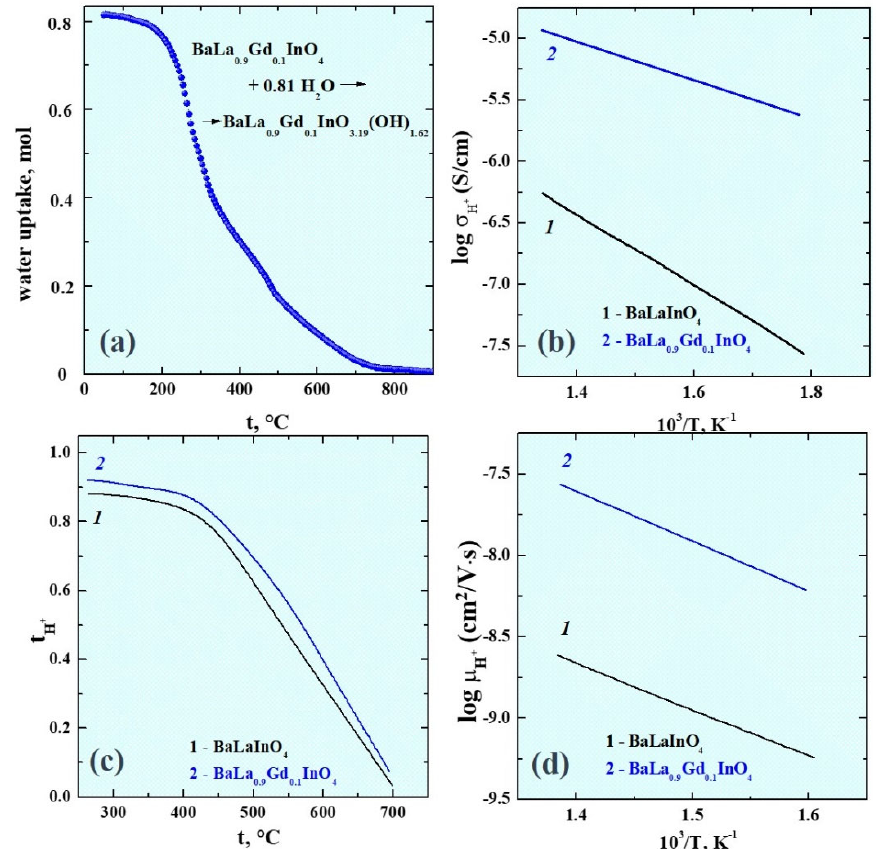
Figure 3. TG-curve for BaLa 0.9 Gd 0.1 InO 4 composition ( a ); temperature dependencies of protonic conductivity ( b ) and mobility ( d ) and protonic transport numbers ( c ) for doped BaLa 0.9 Gd 0.1 InO 4 and undoped BaLaInO 4 compositions.